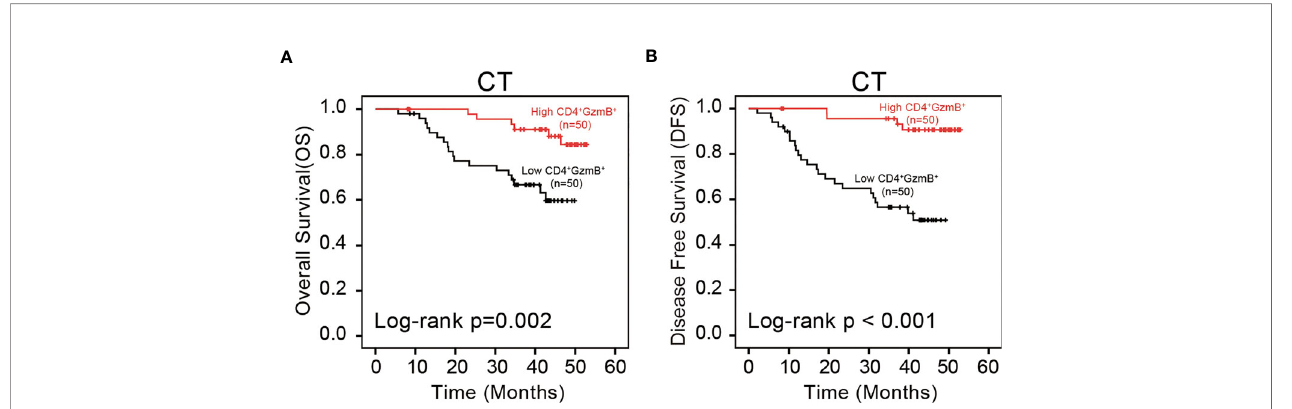
FIGURE 4 | Assessment of the prognostic value of CD4 + GzmB + T cells in pMMR CRC. (A) Kaplan-Meier curves illustrate the duration of overall survival (OS) and (B) disease free survival (DFS) associated with the densities of CD4 + GzmB + T cells in fi ltrated in central tumor region. The red and black lines represent the high-cell- density and